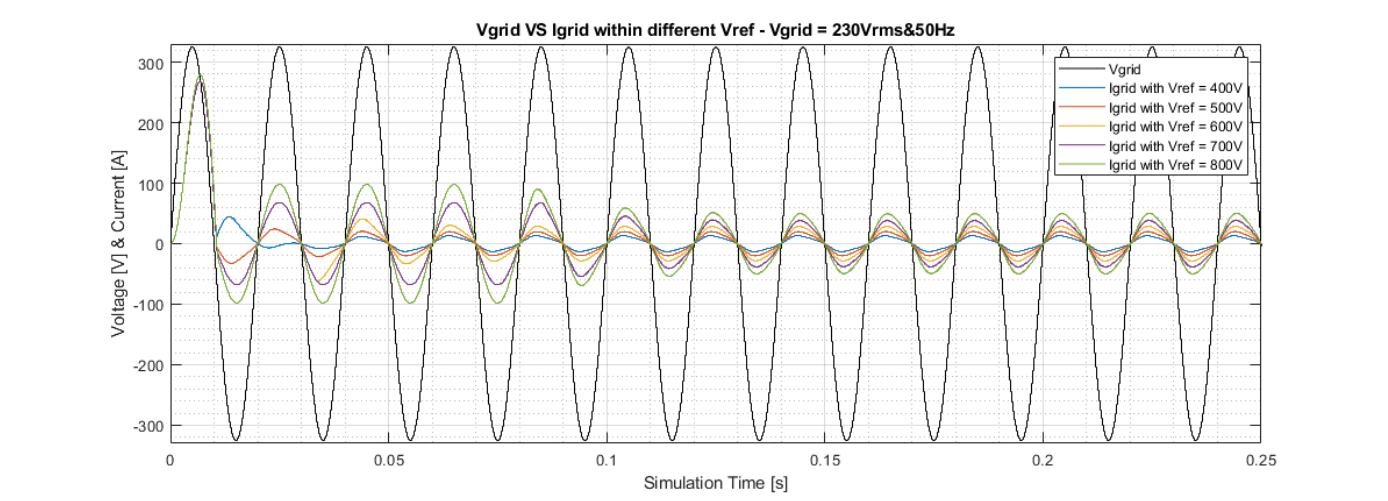
Figure 19. Current control within V ref different scenarios when V grid = 230 Vrms and 50